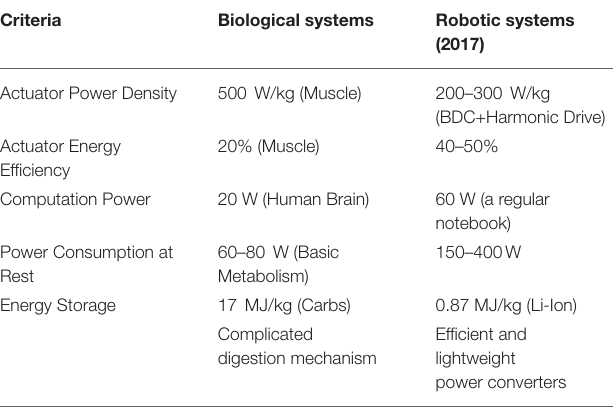
TABLE 1 | Energetics comparison of biological and robotic systems.